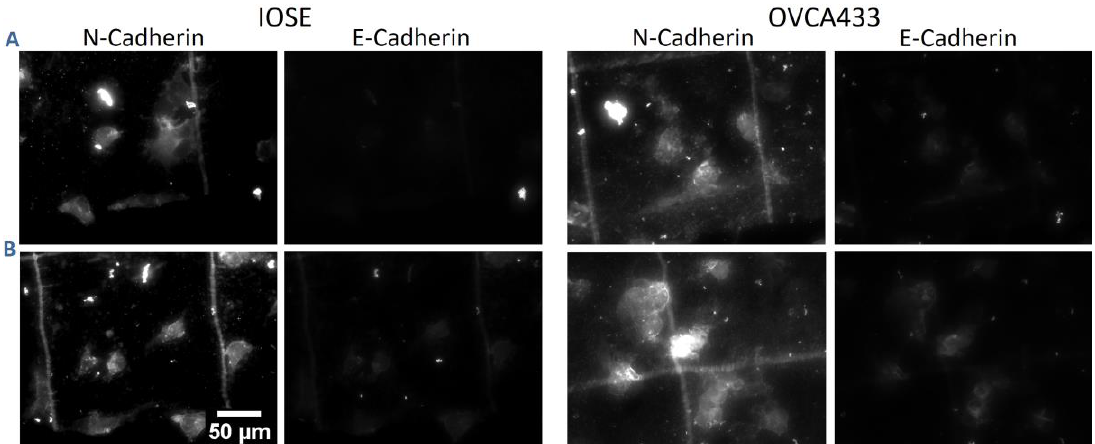
Figure 10. Representative immunofluorescence images of IOSE and OVCA433 cells stained with primary anti-E-cadherin and anti-N-cadherin antibodies and a secondary antibody conjugated with Alexa Fluor 488 and Alexa Fluor 594, respectively. ( A ) Normal and ( B ) high-grade models. Scale bar = 50 µm.